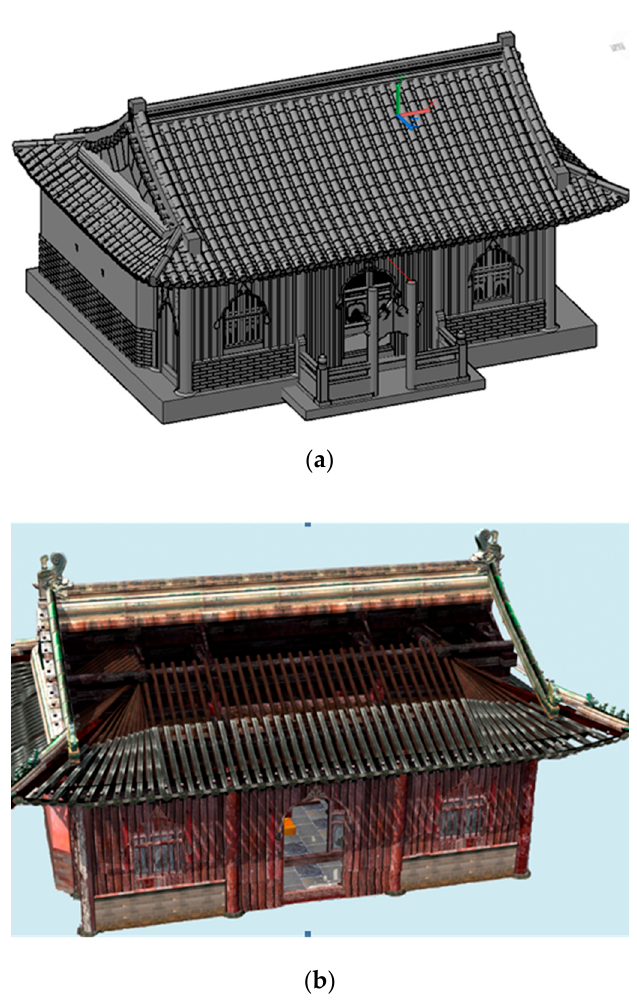
Figure 16. Reconstructive 3D model of Liangyi Temple. ( a ) Rendered with gray image; ( b ) rendered with texture mapping.